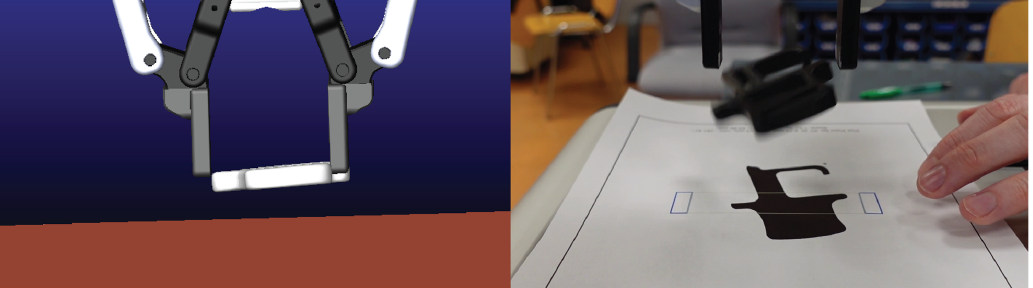
Figure 18. Graphical analysis of the third pick-point. Source: own.